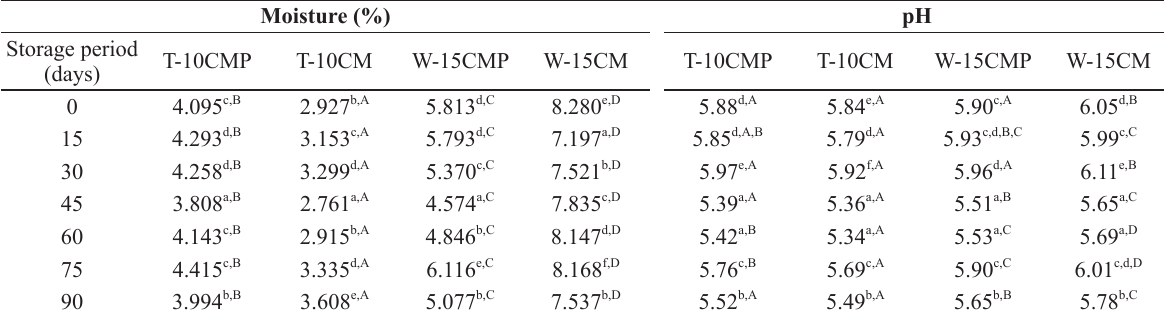
Moisture and pH of the